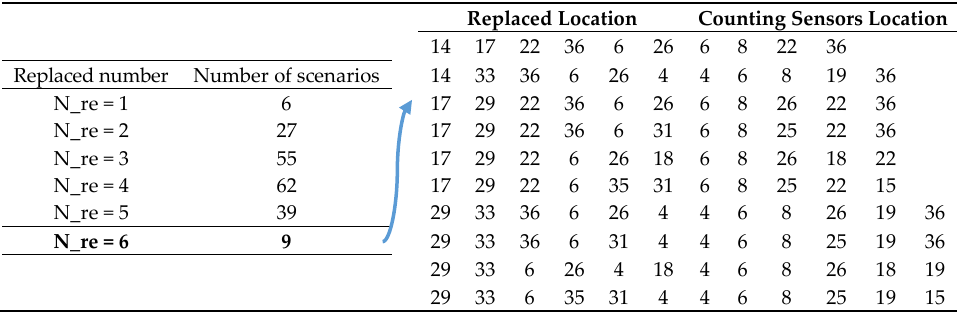
Table 8. Combination deployment schemes for the Nguyen-Dupuis network.